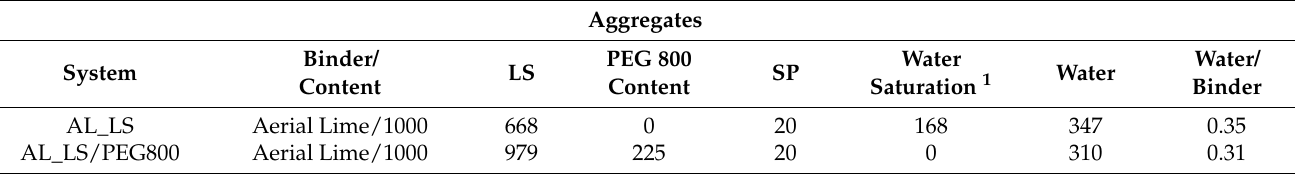
Table 2. Mortar compositions (reported as kg/m 3 of produced